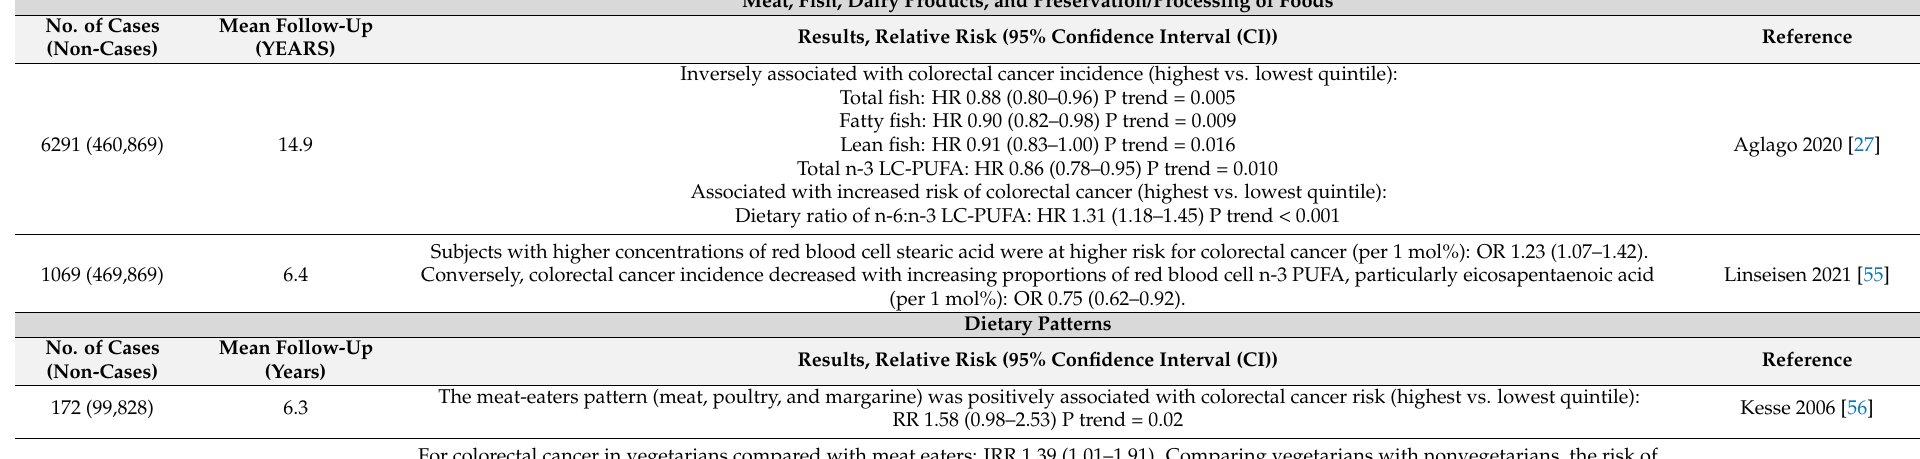
Meat, Fish, Dairy Products, and Preservation/Processing of Foods No. of Cases Results, Relative Risk (95% Confidence Interval (CI)) Reference Inversely associated with colorectal cancer incidence (highest vs. lowest quintile): Total fish: HR 0.88 (0.80–0.96) P trend = 0.005 14.9